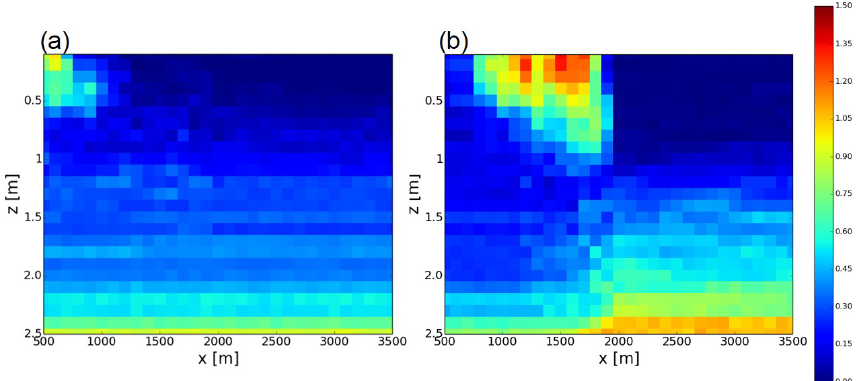
Figure 4. The Kullback–Leibler divergence of the NoDA experiment generated by (a) the LOW_K reference and (b) the HIGH_K reference at t = 130h (see also Fig. 1b and